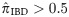
Proportions of significant negative spatial trend estimates with respect to data subset sample size.Spatial trend estimates were based on regression of highly related parasite sample pair labels (equal to 1 if π^IBD>0.5  and 0 otherwise) onto distance, within temporally adjusted models (βadjusted ΔDistance (km) for barcode data, and βadjusted 2014 ΔDistance (km) for WGS data).